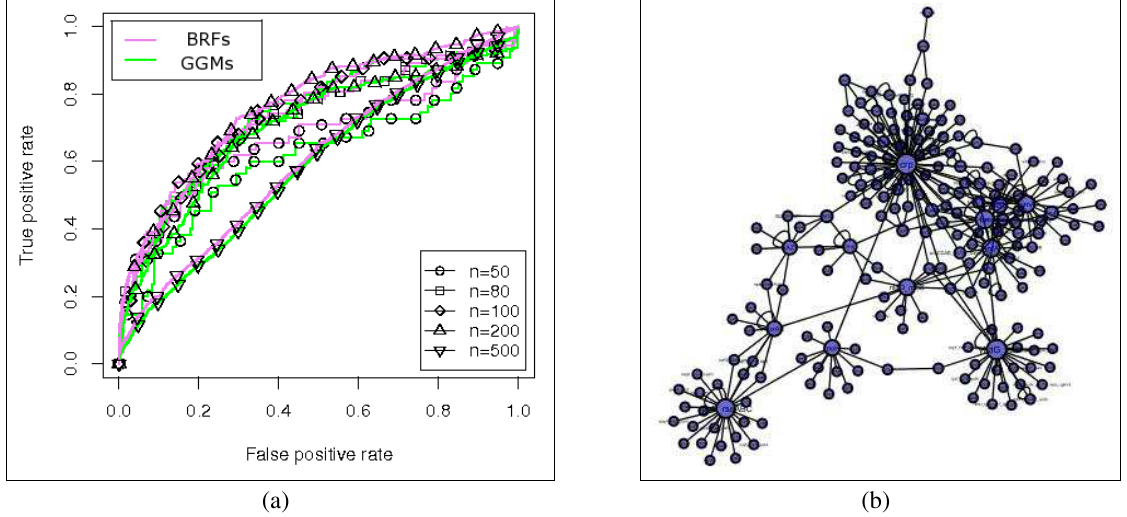
Figure 1: (a) ROC for comparison of GGMs and the proposed model on five synthetic networks of various size, (b) An example network of 200